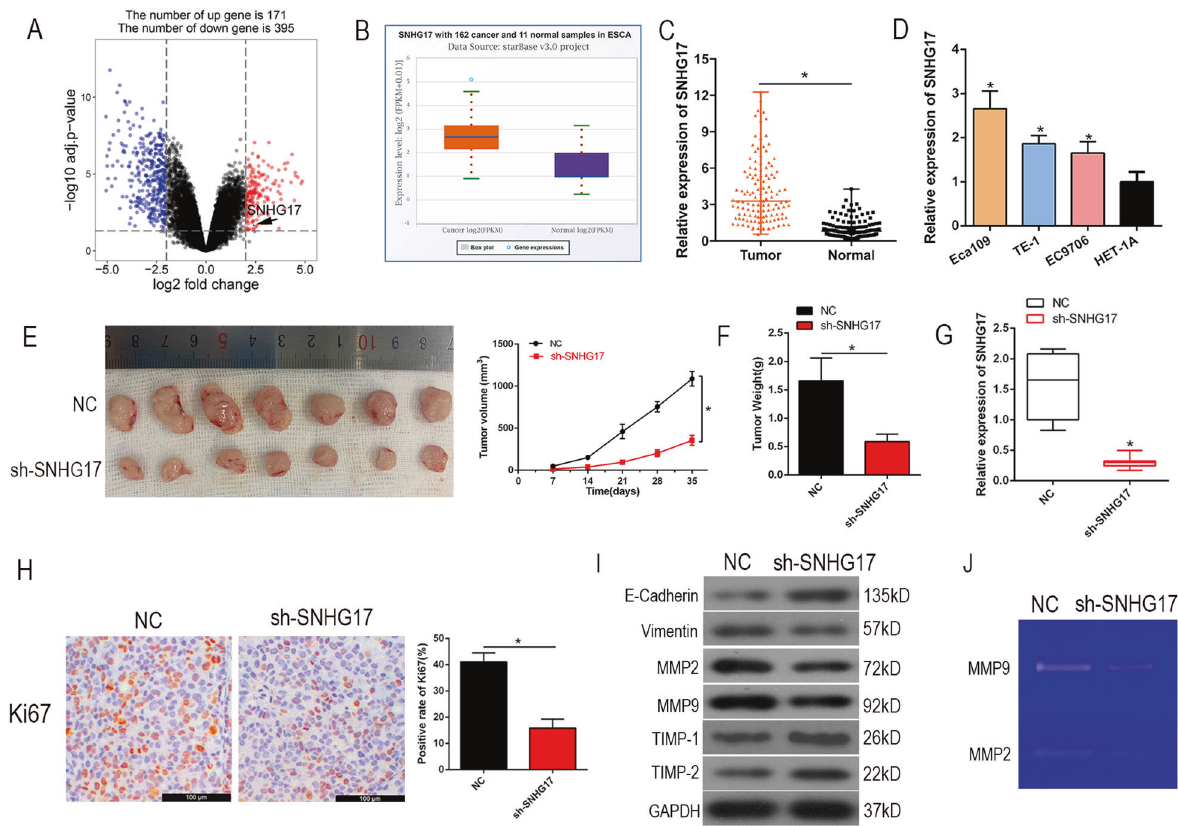
Fig. 1 SNHG17 is overexpressed in ESCC tissues and cell lines and SNHG17 knockdown suppresses tumor growth of ESCC in vivo. A , B The results from the GEO database and starBase showed that SNHG17 expression was obviously upregulated in ESCC tissues compared with normal tissues. The fold change (FC) of genes was assessed by log transformation. |logFC| > 2 and adjusted P < 0.05 were de fi ned as the screened threshold. C , D Expression levels of SNHG17 in clinical samples and cell lines were detected by RT-qPCR. E , F The tumor volume, weight, and morphology were present. G The levels of SNHG17 in xenograft tissues were measured by RT-qPCR. H Immunostaining of Ki-67 in xenograft tissues was performed derived from sh-SNHG17 transfected Eca109 cells. I EMT-related key proteins E-cadherin, Vimentin, MMP2, MMP9, TIMP-1 and TIMP-2 were detected by Western blot after knockdown of SNHG17 compared with control. J Gelatin zymography of activated MMP9 and MMP2 in NC and sh-SNHG17 xenograft tissues. * P < 0.05 vs. control